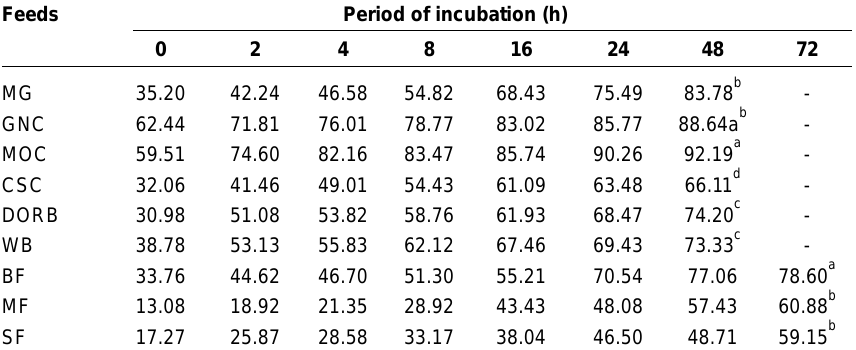
Table-3: In situ DM disappearance (%) of feedstuffs Feeds Period of incubation (h)